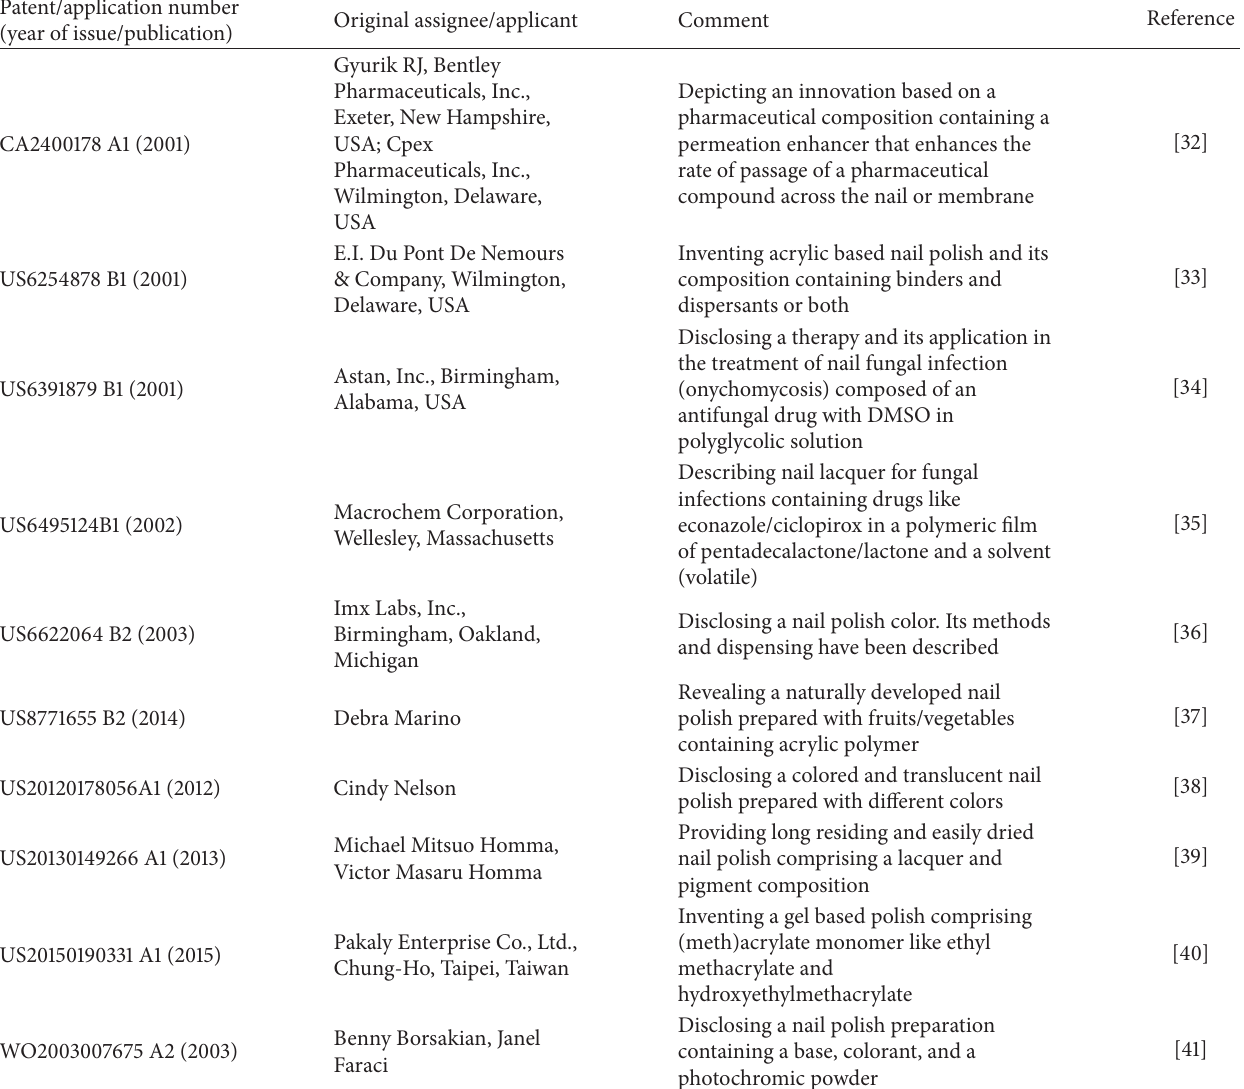
Table 5: Patent reports on nail lacquer for transungual drug